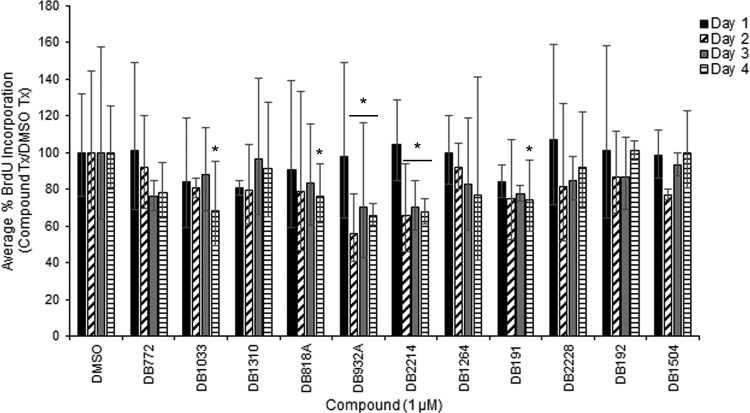
Effect of preliminary hit DB compounds on cell proliferation. PrPSc-positive hTERT-ovine microglia were treated for 4 days with 1 μM DB compound, during which cell proliferation was quantified daily by 24-h BrdU incorporation. Bars represent the average percent BrdU incorporation in DB compound-treated cells relative to that in day-matched, vehicle control (0.1% DMSO)-treated cells. Error bars represent the 95% confidence intervals from the averages from 3 independent experiments. Values were statistically compared to the day-matched vehicle controls to determine enhanced or reduced cell proliferation (*, PDun < 0.05).